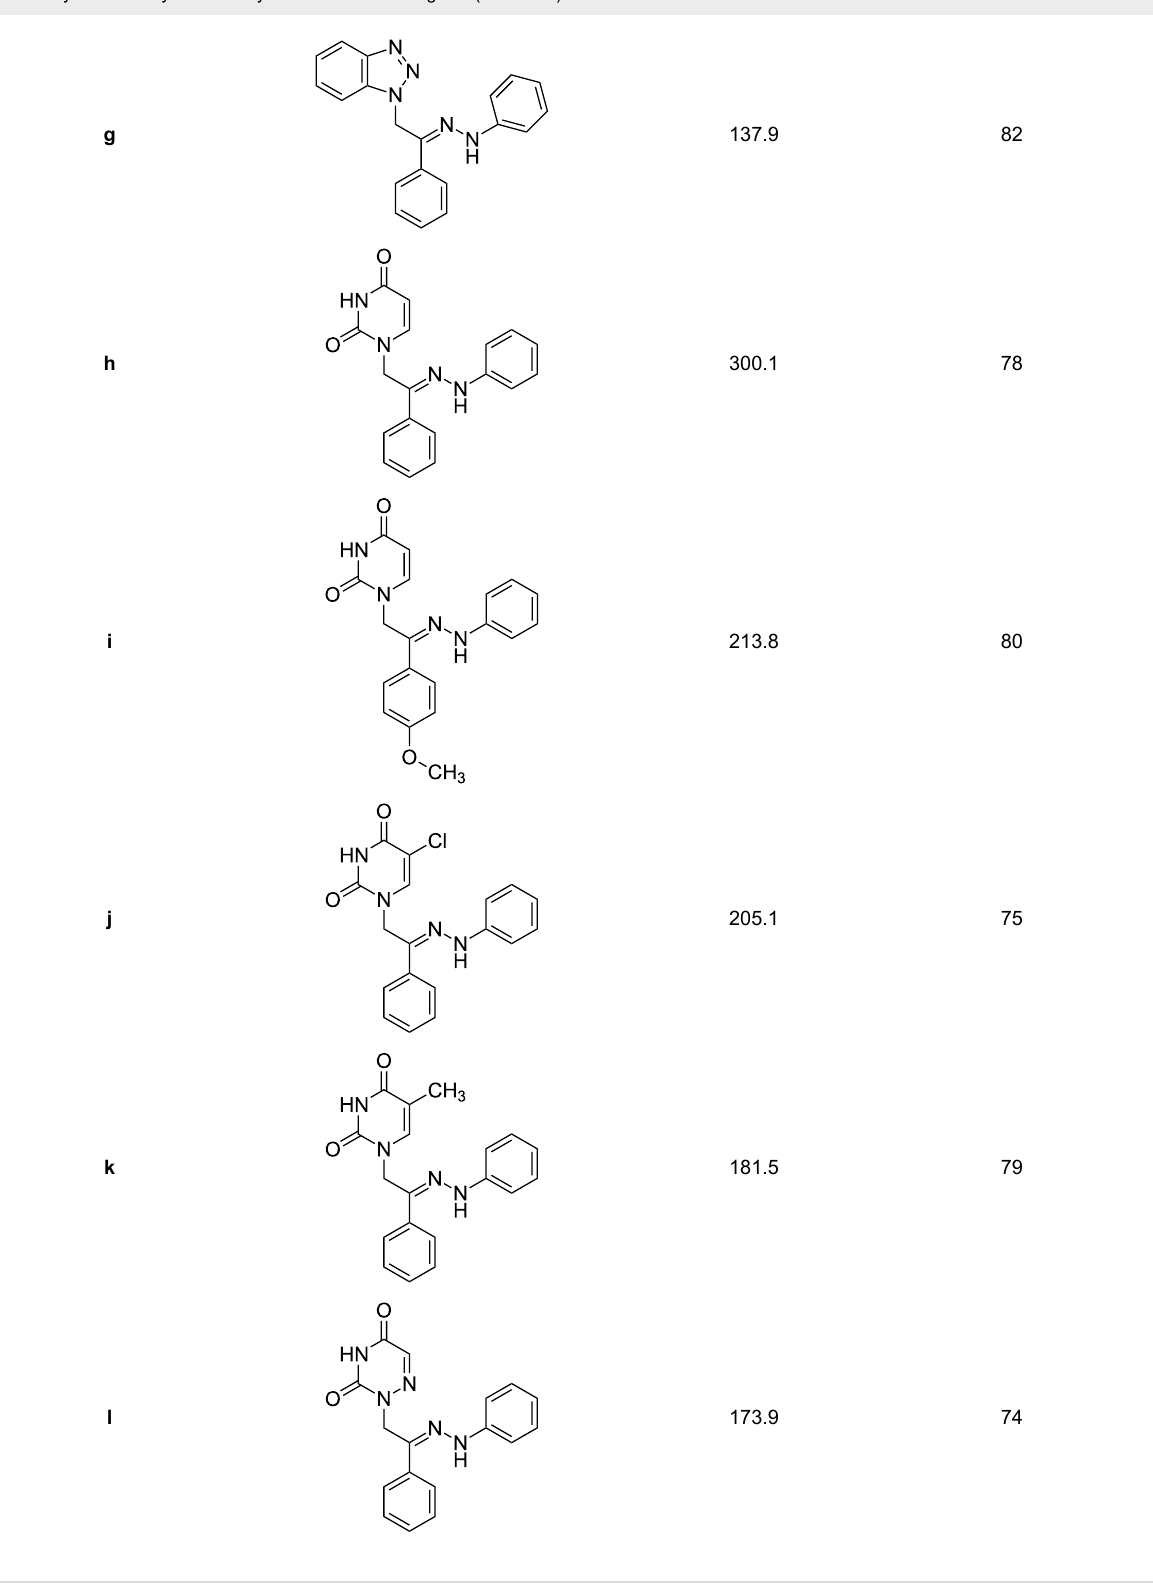
Table 1: Synthesized hydrazono acyclic nucleoside analogues.